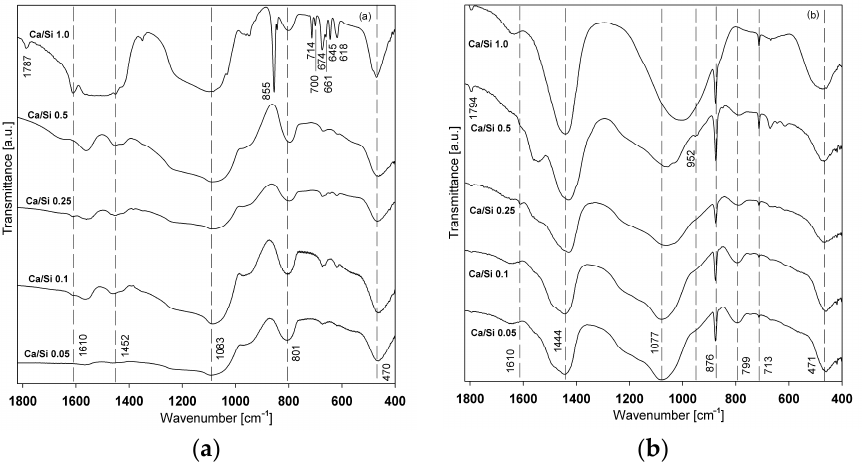
Figure 7. FTIR spectra of Ca/Si systems: ( a ) before calcination, ( b ) after calcination.